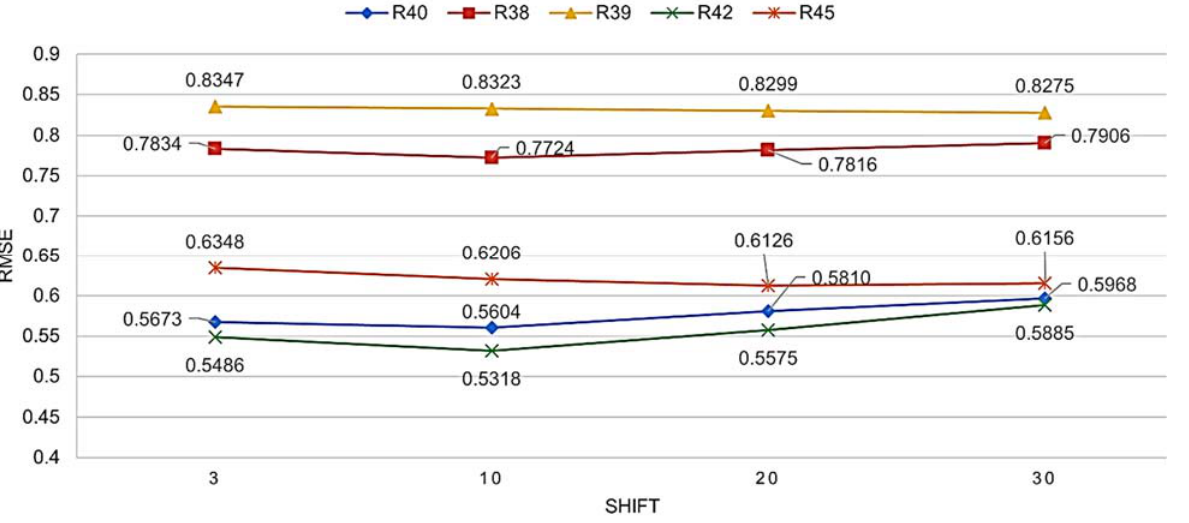
Figure 8. Average RMSE concerning shifts applied to outdoor temperature in predicting indoor temperature for validation set and 2 h prediction horizon.